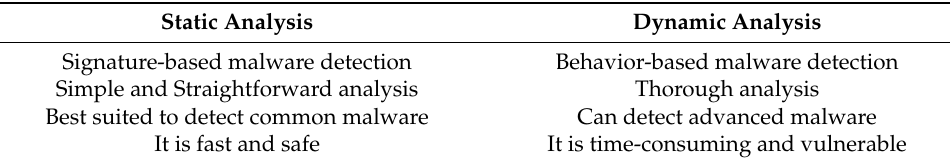
Table 1. Comparison between static analysis and dynamic